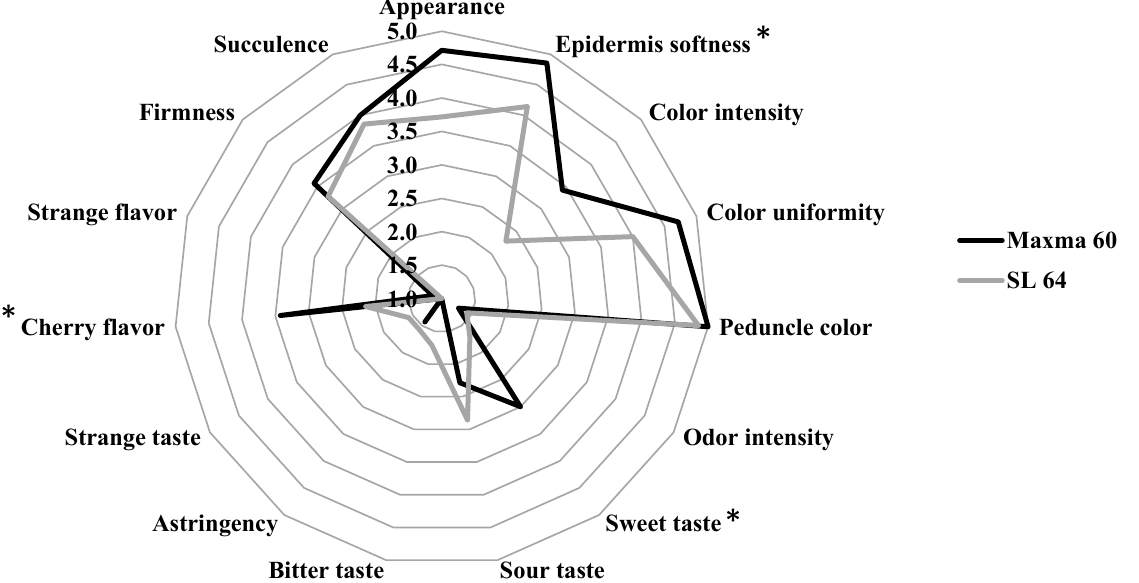
Figure 1. Sensory profile of sweet cherry cv. Early Bigi grafted on SL 64 and Maxma 60 rootstocks. * indicates statistically significant differences ( p < 0.05) between rootstocks for the respective attribute, according to Duncan´s test.